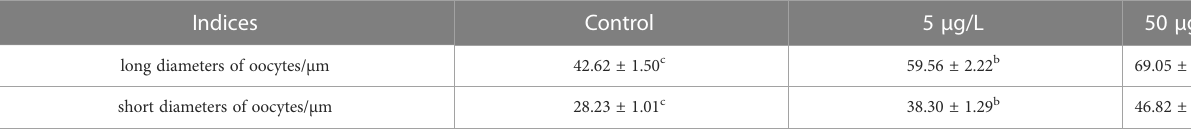
Data are meant ± SE. Different superscript letters indicate that means are signi fi cantly different